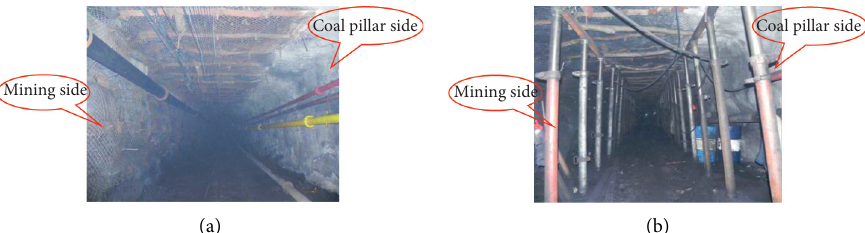
Figure 6: Control effects of surrounding rocks on the belt cross-heading of the 8105 caving face. (a) One year late after driving. (b) Influenced by